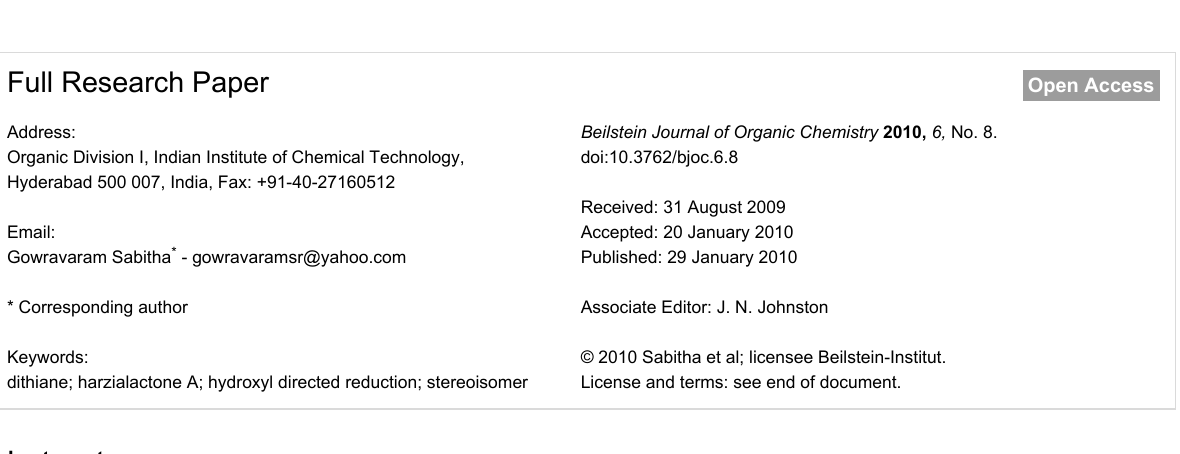
Figure 1: Natural harzialactone A ( 1 ), and its (3 R ,5 S )-isomer ( 2 ).